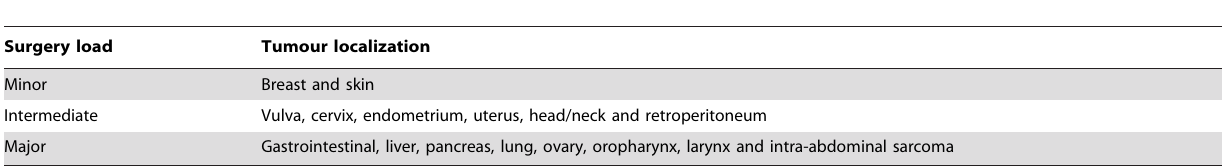
Table 1. Classification of the type of surgery by duration of the procedure and tumour localization.